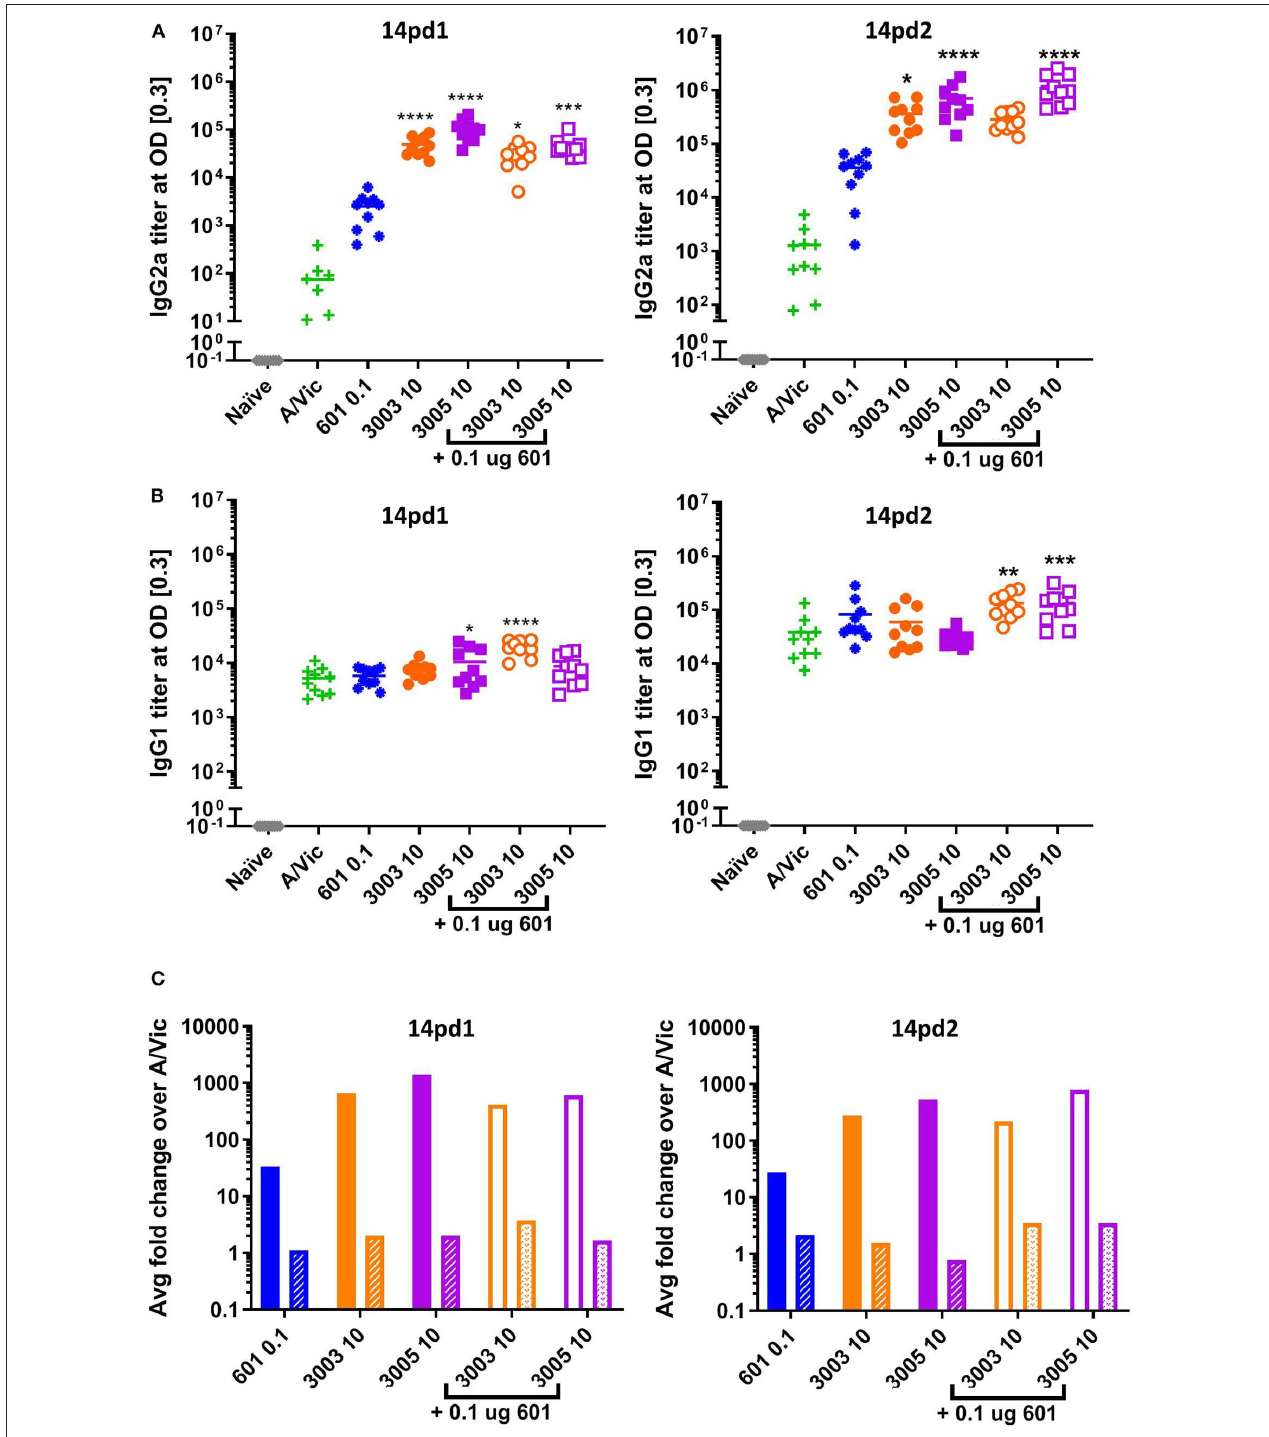
FIGURE 4 | Th1 humoral bias is maintained after two vaccinations. Balb/c mice (10 per group) were vaccinated i.m. with A/Vic detergent-split monovalent influenza vaccine (0.3 µ g/mouse) with indicated adjuvants (CRX-601 = 0.1 µ g/mouse, UM-3003 or UM-3005 = 10 µ g/mouse). At 14dp1 and 14dp2 mice were bled and influenza-specific IgG2a (A) and IgG1 (B) titers were measured. (C) Fold change of adjuvanted IgG2a (solid bars) or IgG1 (patterned bars) compared to non-adjuvanted control (A/Vic only) at 14dp1 (left) and 14dp2 (right). Lines indicate mean. Statistical signficance determined by one-way ANOVA followed by Fishers LSD for multiple comparisons (GraphPad Prism 7); asterisks indicate significance compared to the A/Vic alone group (green “ + ”) where * p ≤ 0.05, ** p ≤ 0.01, *** p ≤ 0.001, **** p ≤ 0.0001.